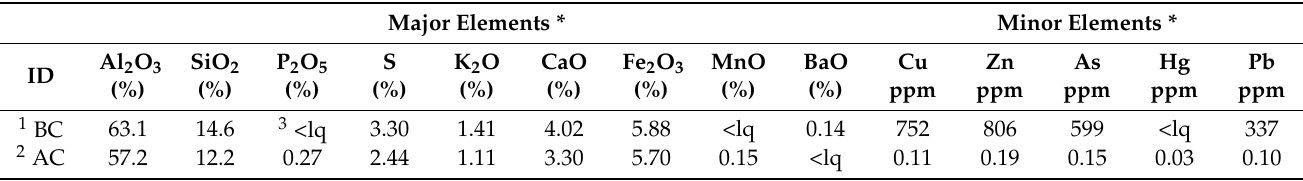
Table 1. Chemical composition of mining